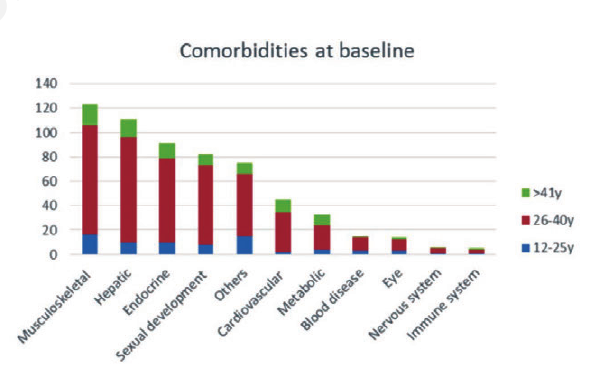
Figure 2. Comorbidities classified according to IC-10 disease cat- egories: total number, age and percentage.